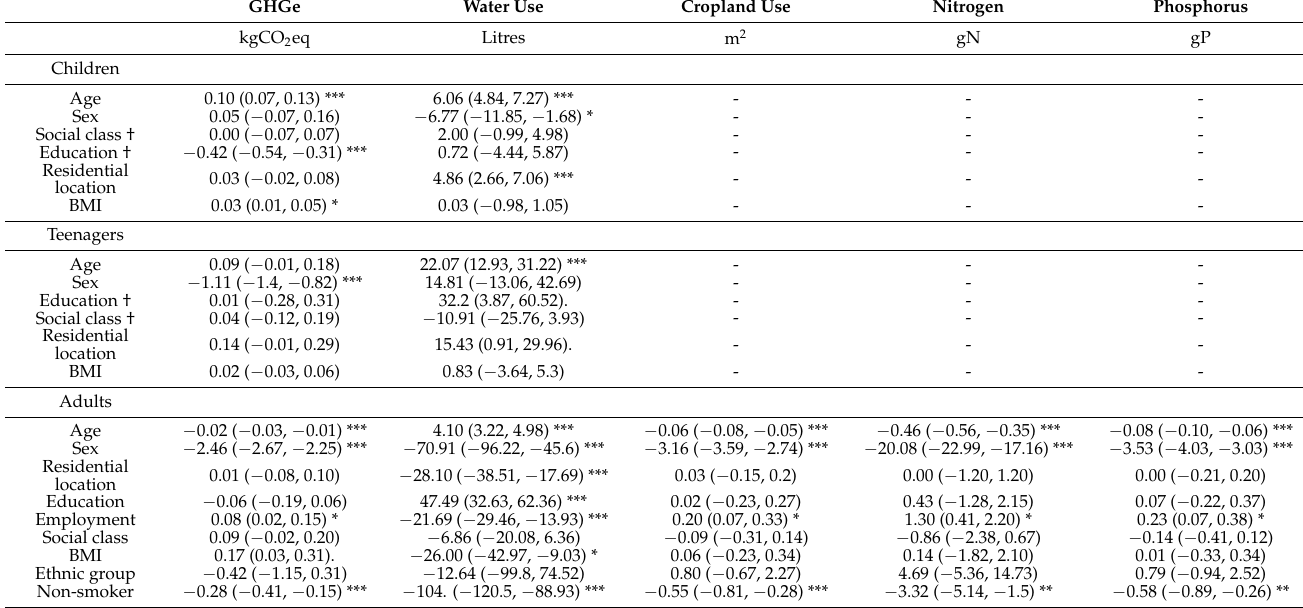
Abbreviations: CO 2 = carbon dioxide. m 2 = metres squared. g = grams. n = nitrogen. p = phosphorous. BMI = body mass index. Multiple linear regression results corrected for significant factors. Values shown